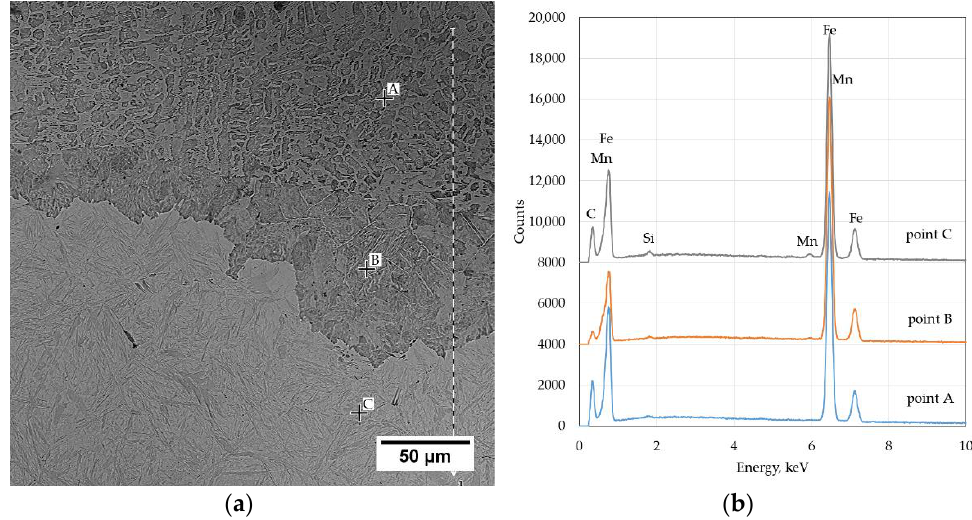
Figure 4. The results of the microanalysis of the chemical composition in the areas A, B, and C, performed on a SEM-EDS: ( a ) microstructure; ( b ) SEM-EDS results The Si content at the cutting surface is 0.14% and Mn 0.3% (Table 2). This area is